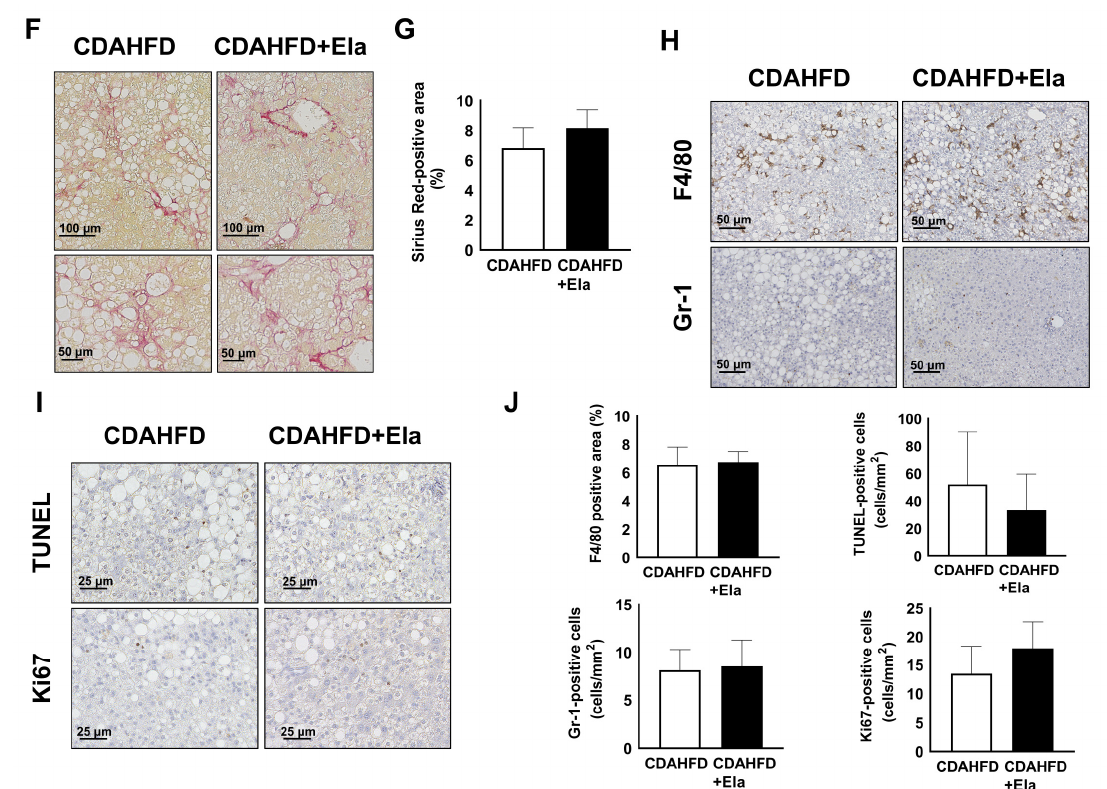
Figure 6. Elafibranor prevented the progression of steatosis and ballooning but not fibrosis. Schematic figure in the therapeutic study with Elafibranor using CDHFD-fed chimeric mice ( A ). Time course changes in the blood h-Albumin ( B ) and human specific ALT1 levels ( C ) of the CDAHFD with (closed triangle) or without (closed circle) Elafibranor. Representative images of H&E staining in the livers of CDAHFD-fed mice with or without Elafibranor ( D ). Scale bar: 50 µ m. Representative images of Oil Red O staining ( E ) in the liver of CDAHFD with or without Elafibranor. Scale bar: 100 µ m. Representative images of Sirius Red staining in the liver of CDAHFD with or without Elafibranor ( F ). Scale bar: 100 µ m (upper), 50 µ m (lower). The ratio of the Sirius Red-positive area in the livers of CDAHFD-fed mice with or without Elafibranor ( G ). Results are represented as the mean ± standard deviation ( n = 4). Representative images of F4/80 and Gr-1 immunostaining in the livers of CDAHFD-fed mice with or without Elafibranor ( H ). Scale bar: 50 µ m. Representative images of Ki67 antibody and TUNEL staining in the livers of CDAHFD-fed mice with or without Elafibranor ( I ). Scale bar: 25 µ m. The ratio of the F4/80-positive area and number of Gr-1-, TUNEL-, and Ki67-positive cells in the livers of CDAHFD-fed mice with or without Elafibranor ( J ). Results are expressed as the mean ± standard deviation ( n = 4). Differences between the two groups were evaluated statistically using an unpaired Student’s t test.